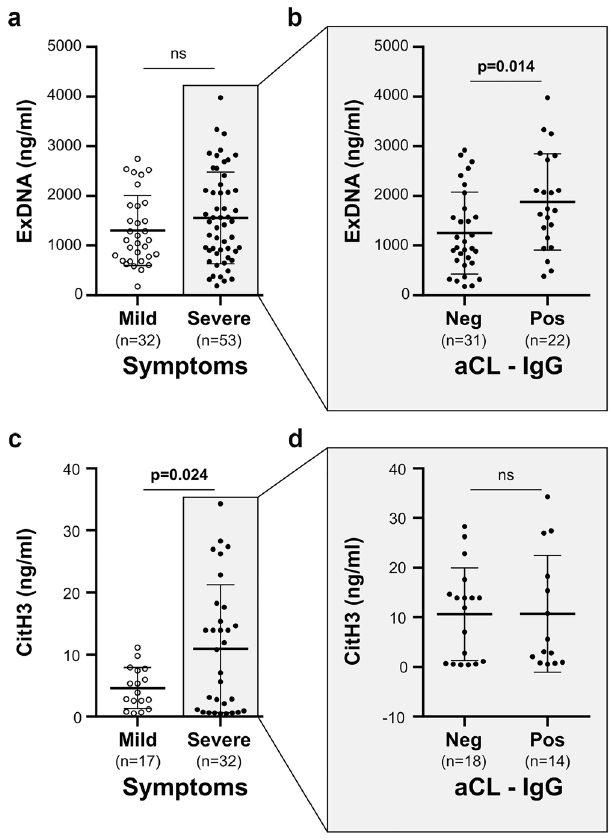
Figure 3. Extracellular DNA and citrullinated histones H3 levels in patients with COVID-19. Extracellular DNA levels in mild/severe COVID-19 patients ( a ) and in aCL IgG positive (Pos)/negative (Neg) patients with severe COVID-19 ( b ). Citrullinated histones H3 levels in mild /severe COVID-19 patients ( c ) and in aCL IgG positive (Pos)/negative (Neg) with severe COVID-19 ( d ). Statistical analysis performed with Student’s t test. aCL anti-cardiolipin, ns not